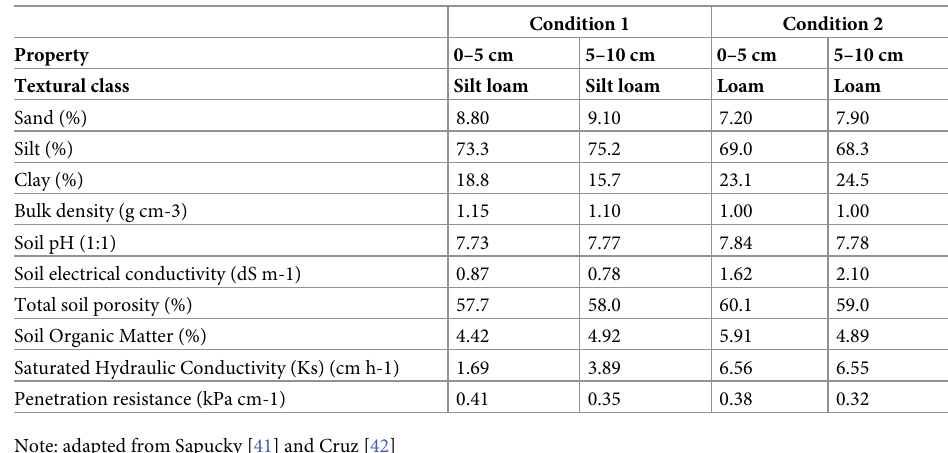
Table 1. Soil properties of sampling sites